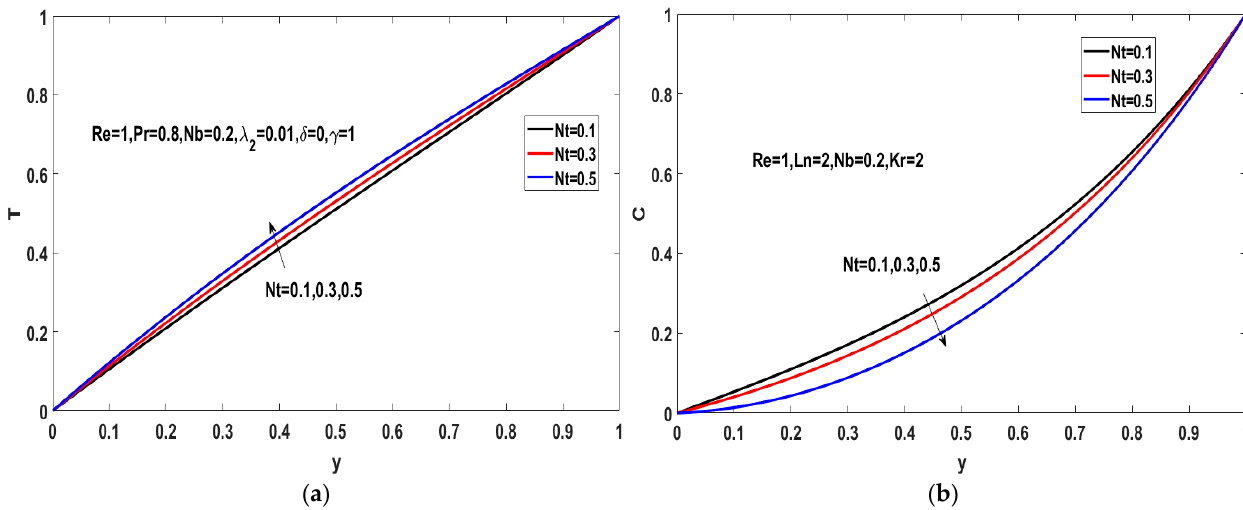
Figure 8. Effects of Nt : ( a ) on temperature distributions; ( b ) on concentration distributions.